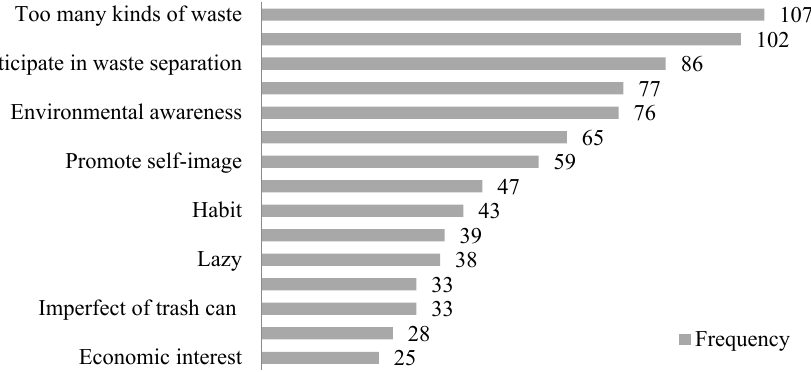
Figure 1. Frequency of key entries in interview data.